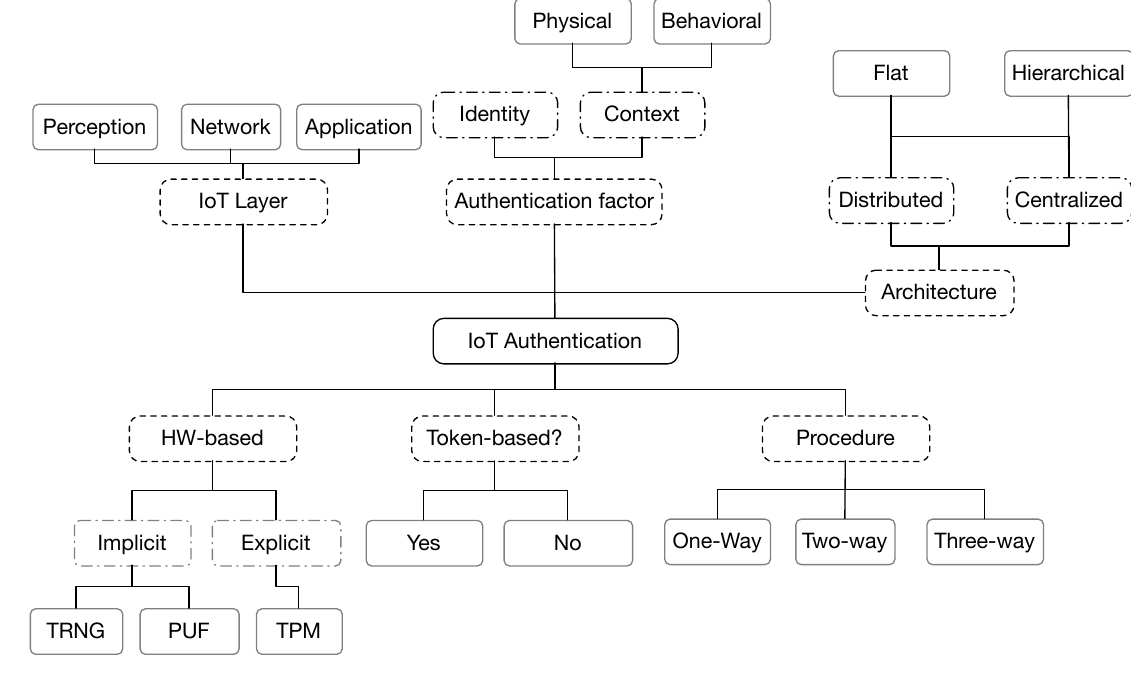
Figure 2. Taxonomy of IoT authentication